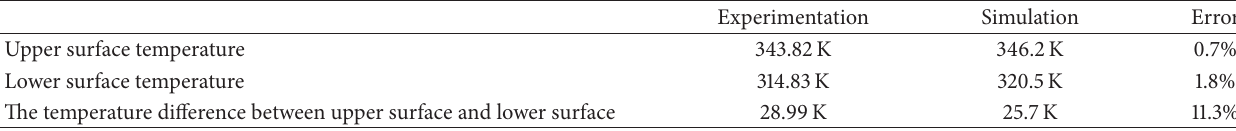
Figure 8: The temperature distribution of test specimen upper surface and lower surface. Table 4: Data of experiment and simulation comparison